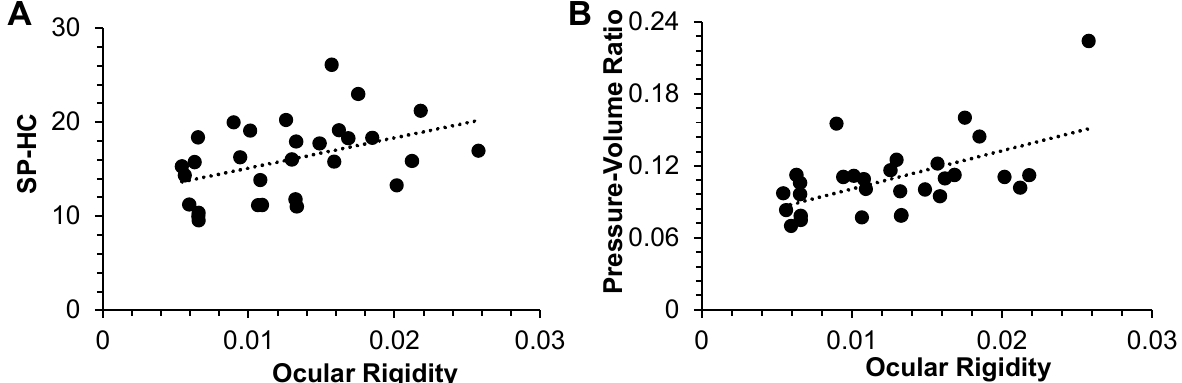
Figure 5. Ocular rigidity was positively correlated with ( A ) SP-HC (R = 0.43; p = 0.018) and ( B ) static pressure-volume ratio (R = 0.57; p = 0.001).